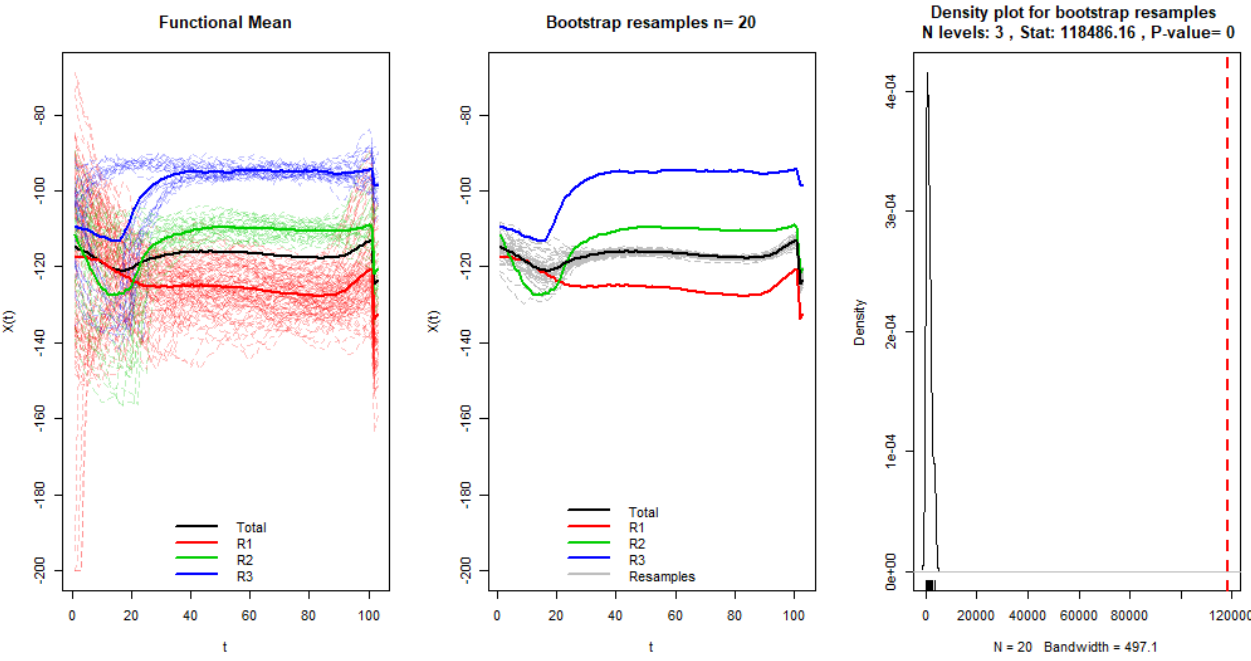
Figure 8. Functional ANOVA results of the analysis of the upper harmonic (USH) trajectories with the motor under low load.